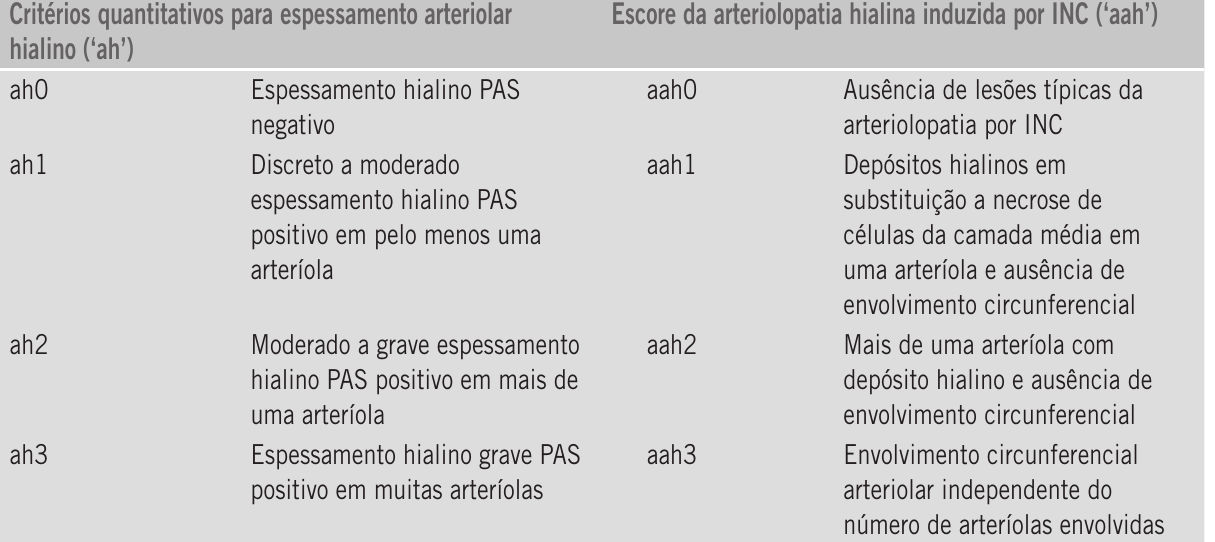
Critérios quantitativos para espessamento